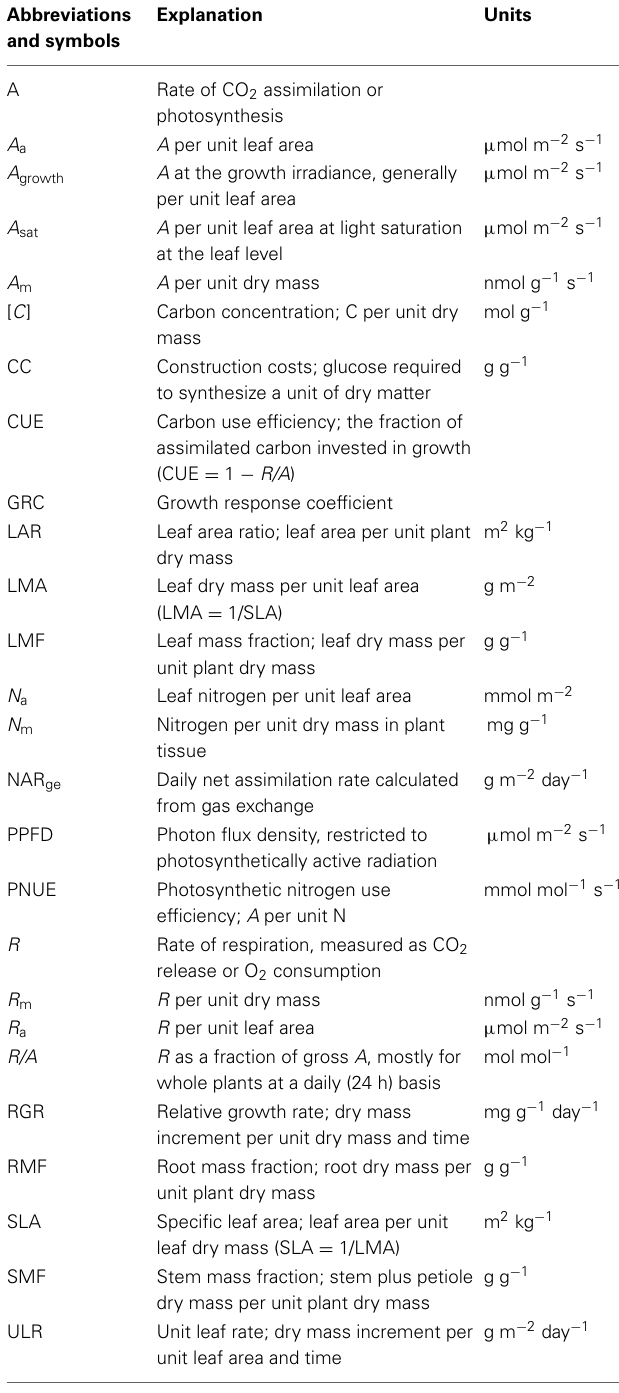
Table 1 | Abbreviations and symbols, definitions of the variables and units used in this